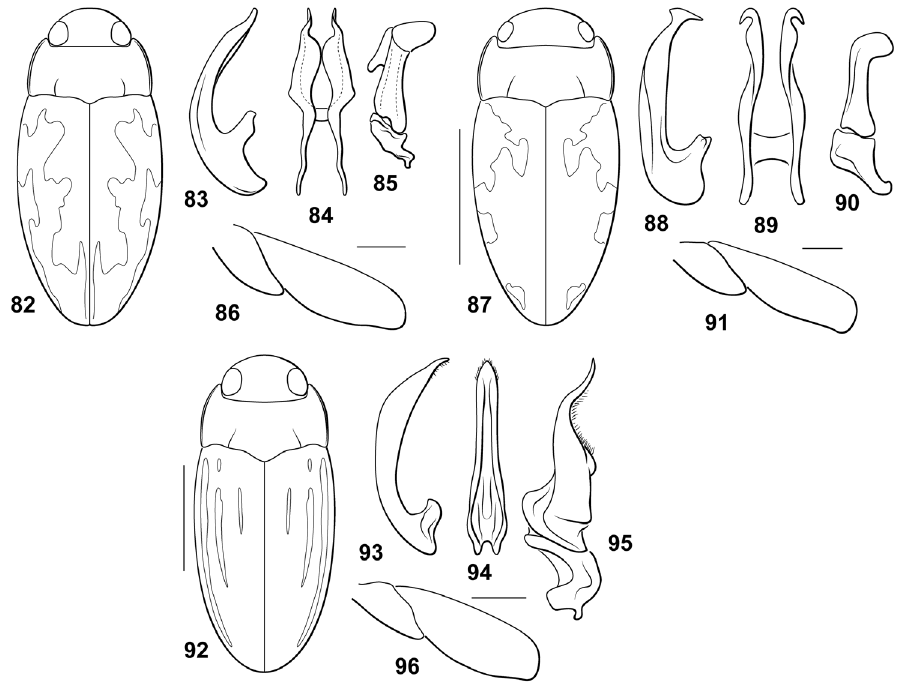
Figures 82–96. Bidessodes species. 82–86 B. semistriatus 82 dorsal habitus, scale = 1 mm 83 male geni- talia 83 median lobe, right lateral aspect 84 median lobe, ventral aspect 85 right lateral lobe, right lateral aspect 86 left metatrochanter and metafemur, anterior aspect, scale = 0.25 mm 87–91 B. subsignatus 87 dorsal habitus, scale = 1 mm 88 male genitalia 88 median lobe, right lateral aspect 89 median lobe, ventral aspect 90 right lateral lobe, right lateral aspect 91 left metatrochanter and metafemur, anterior aspect, scale = 0.25 mm 92–96 B. zimmermanni 92 dorsal habitus, scale = 1 mm 93 male genitalia 93 median lobe, right lateral aspect 94 median lobe, ventral aspect 95 right lateral lobe, right lateral aspect 96 left metatrochanter and metafemur, anterior aspect, scale = 0.25